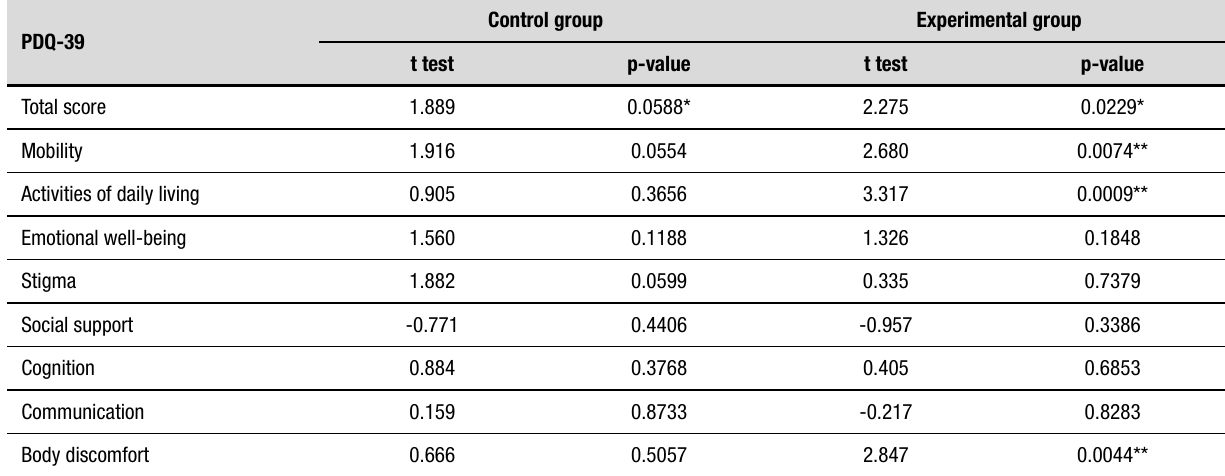
Table 5. Inferential analysis — baseline x post-intervention evaluations. PDQ-39